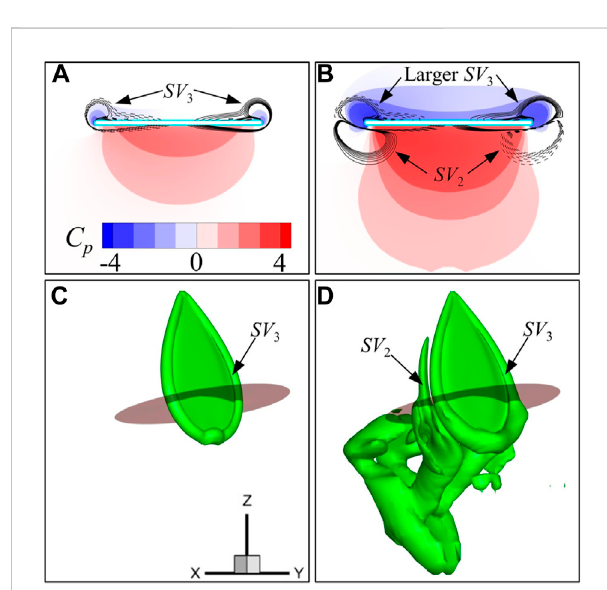
FIGURE 9 Pressure and spanwise vorticity ( ω S ) contours at the 0.7 R wing section, as well as the instantaneous vortex structure (Q (cid:1) 2) of the wing at t */ T * (cid:1) 0 . 125 (A,C) and t */ T * (cid:1) 4 . 125 (B,D) (solid and broken lines indicate positive and negative vorticity,